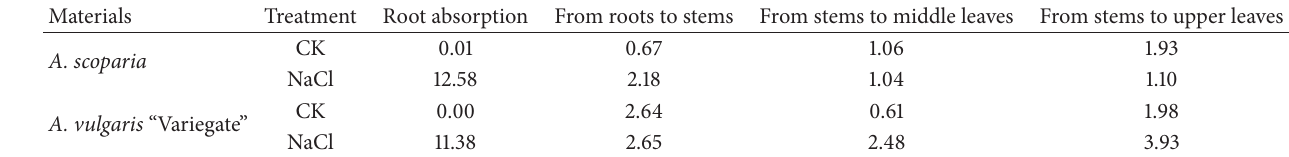
Table 6: Effect of NaCl stress on absorbing and transporting selectivity ratios of K + to Na + in seedlings.